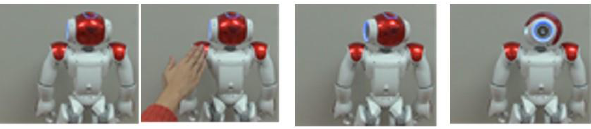
Figure 3. Video stimulus with Nao.